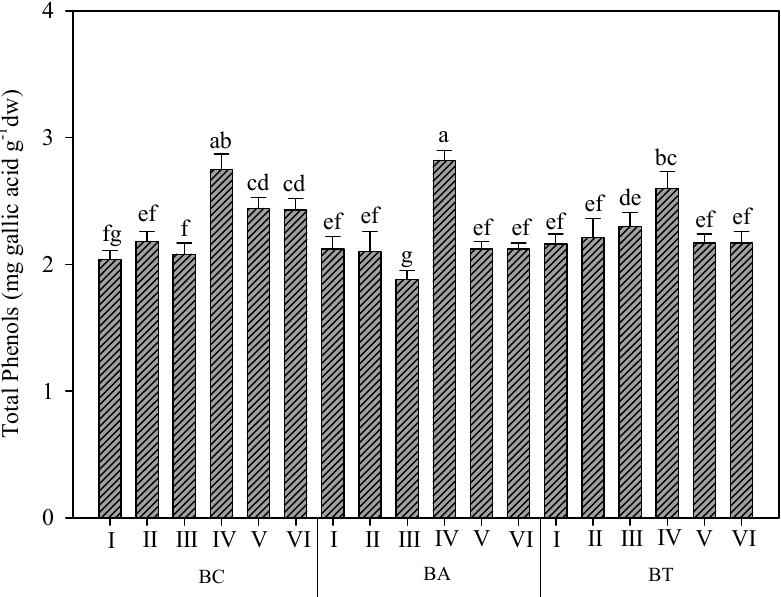
. Figure 2. Effect of biostimulant and harvesting time on total phenol content in Diplotaxis tenuifolia leaves, regardless of salinity level. Different letters indicate significant differences according to Tukey’s honestly significant difference (HSD) test at p = 0.05; Roman numbers (I–VI) indicate the successive harvests; BC: no biostimulants added; BA: plants treated with Auxym®; and BT: plants treated with Trainer®. All data are expressed as mean ± SE (standard error), n = 3. Table 2. Effect of salinity and biostimulant on hydrophylic antioxidant activity (HAA), ABTS an- tioxidant activity, total phenols, and total ascorbic acid (TAA) content in Diplotaxis tenuifolia leaves, regardless of harvesting